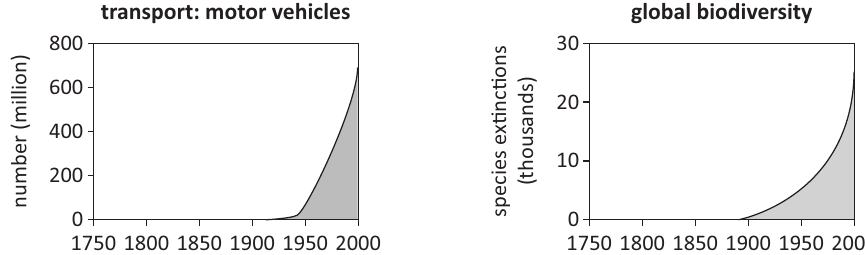
Figure 1. Examples of “The increasing rates of change in human activity since the beginning of Industrial Revolution” and “Global scale changes in the Earth system as a result of the dramatic increase in human activity.” Note: See supplementary materials on the journal’s website for all 24 graphs. Source: Steffen et al. (2011, pp.